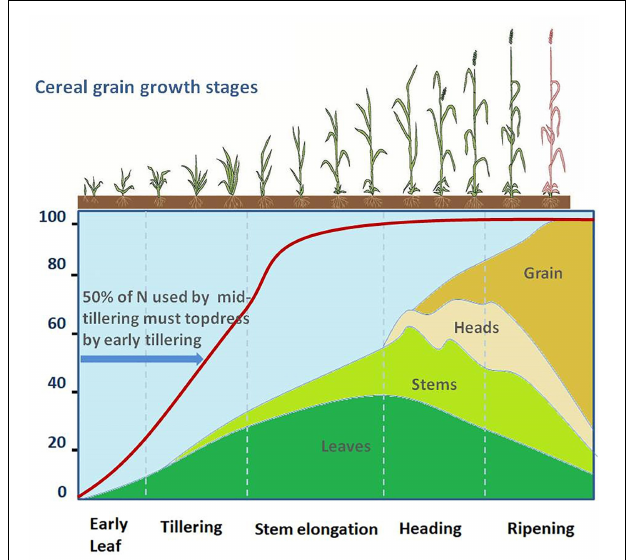
FIGURE 3 | The different stages of growth and development in cereal crops. The red line indicates the requirement of nitrogen at different stages of growth and development, the colored areas under different curves show the accumulation of nitrogen in leaves, stem, head, and grain of spring wheat as a percent of maximum nitrogen. Source: Adapted and modified from Miller et al.